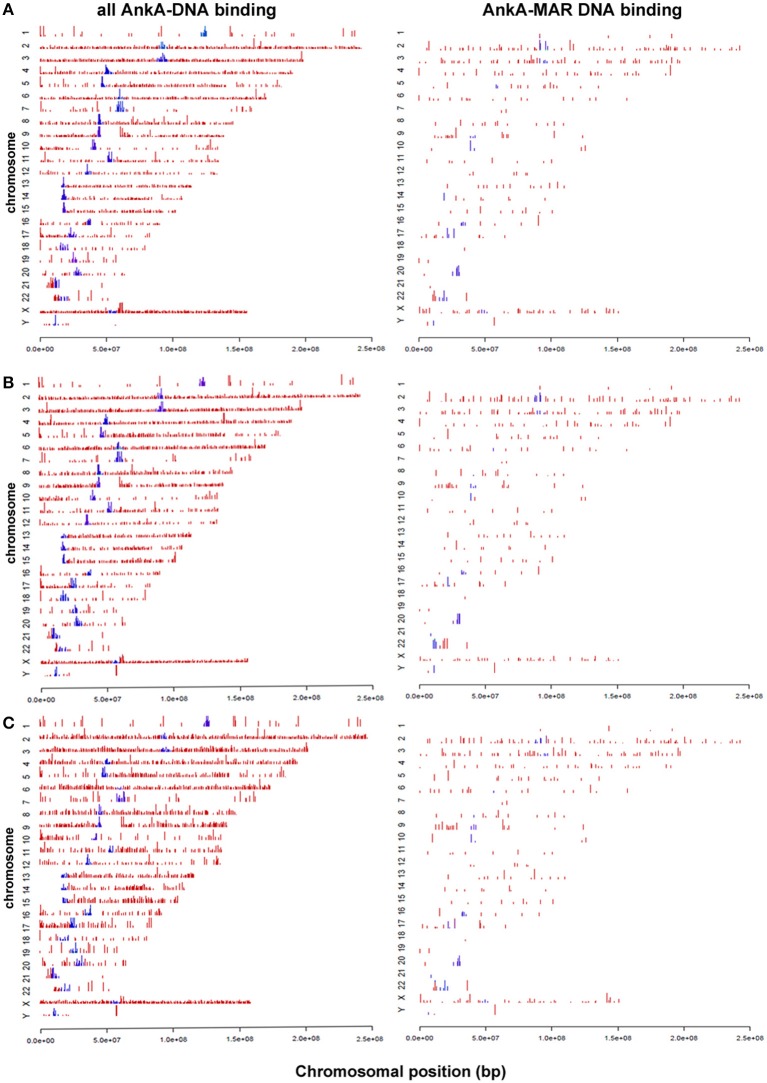
AnkA binding sites across all chromosomes for each of 3 human neutrophil genomic DNA preparations (A–C). The left panels show the specific distribution and binding sites of AnkA to DNA. The right panels show the binding sites of AnkA to MARs identified across the genome using SMARTest (Genomatix) that predicts such regions based primarily on AT content. Blue bars represent AnkA binding at centromeres. Note the reproducible patterns and density of DNA binding and MAR binding by AnkA across all 3 neutrophil DNA preparations, and the marked enrichment at most centromeres.